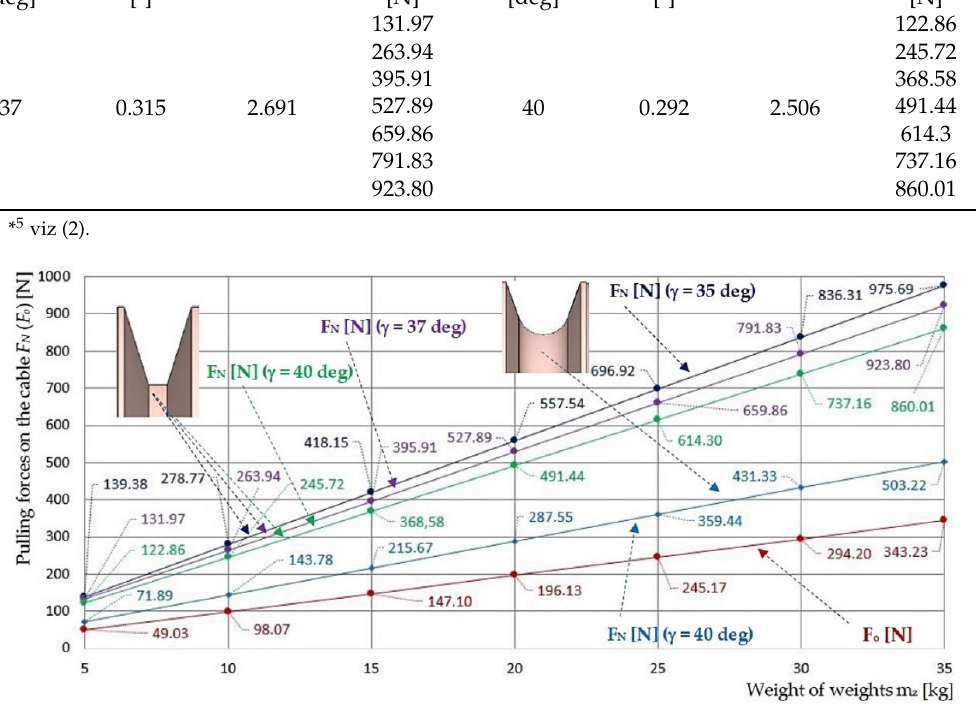
Figure 8. Pulling forces F N and F o on the cable on the advancing and retreating side of the pulley of the laboratory device.